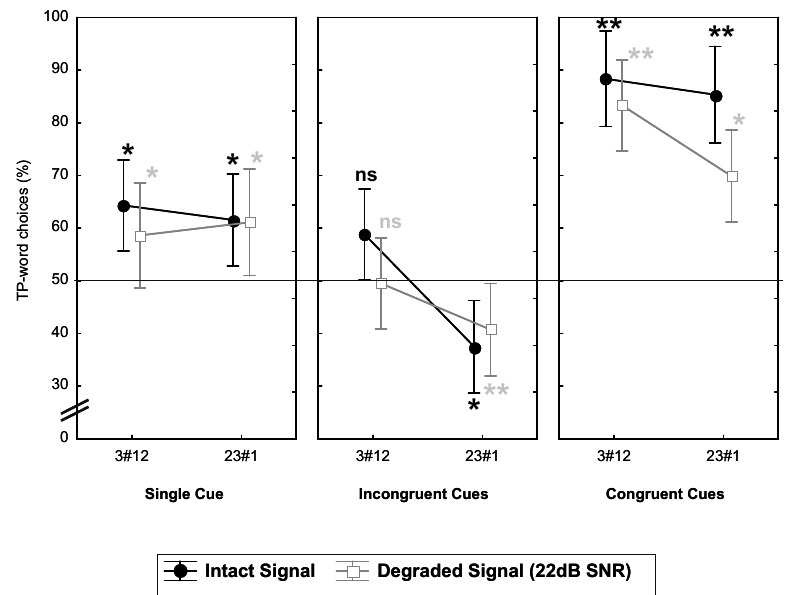
Figure 1: ALL performance pattern (proportion of TP-word choices, in percentage) broken- -down by part-word type (3#12; 23#1), according to signal quality (intact; degraded) and cue-condition (single-cue; incongruent-cues; congruent-cues) in Experiment 1. Vertical bars denote standard error of the mean on each condition. Chance level corresponds to 50%. Level of significance for local one-sample t-test comparisons with chance-level is also indicated (i.e., ns: p > .10; *: p < .05; **: p 